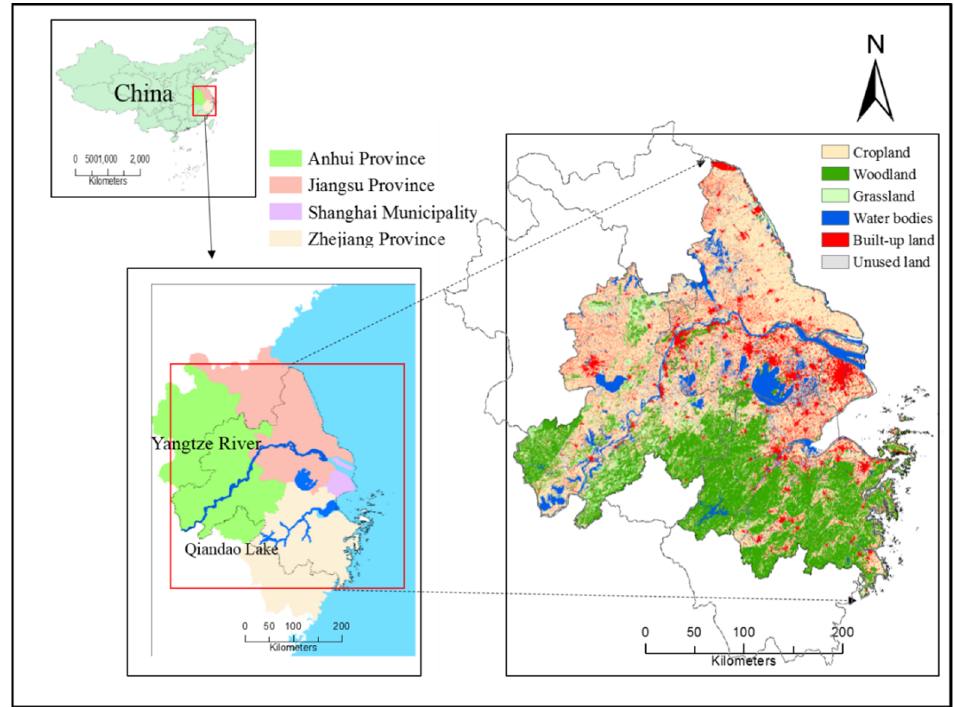
Figure 1. Location and land use/land cover of Yangtze River Delta Region (2015).